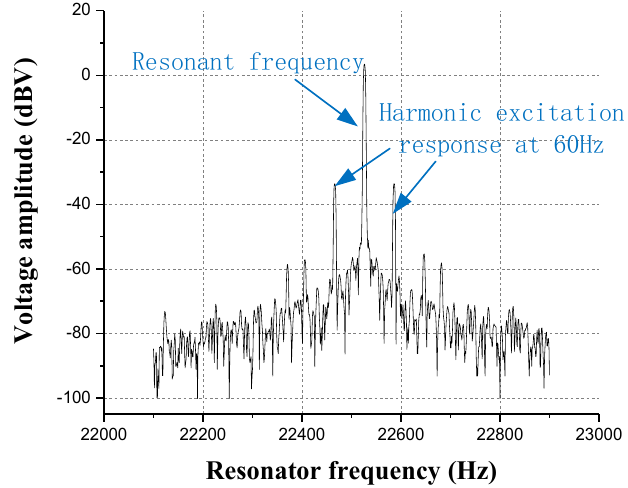
Figure 18. The amplitude-frequency characteristic curve of the resonator excited by the oscillatory air